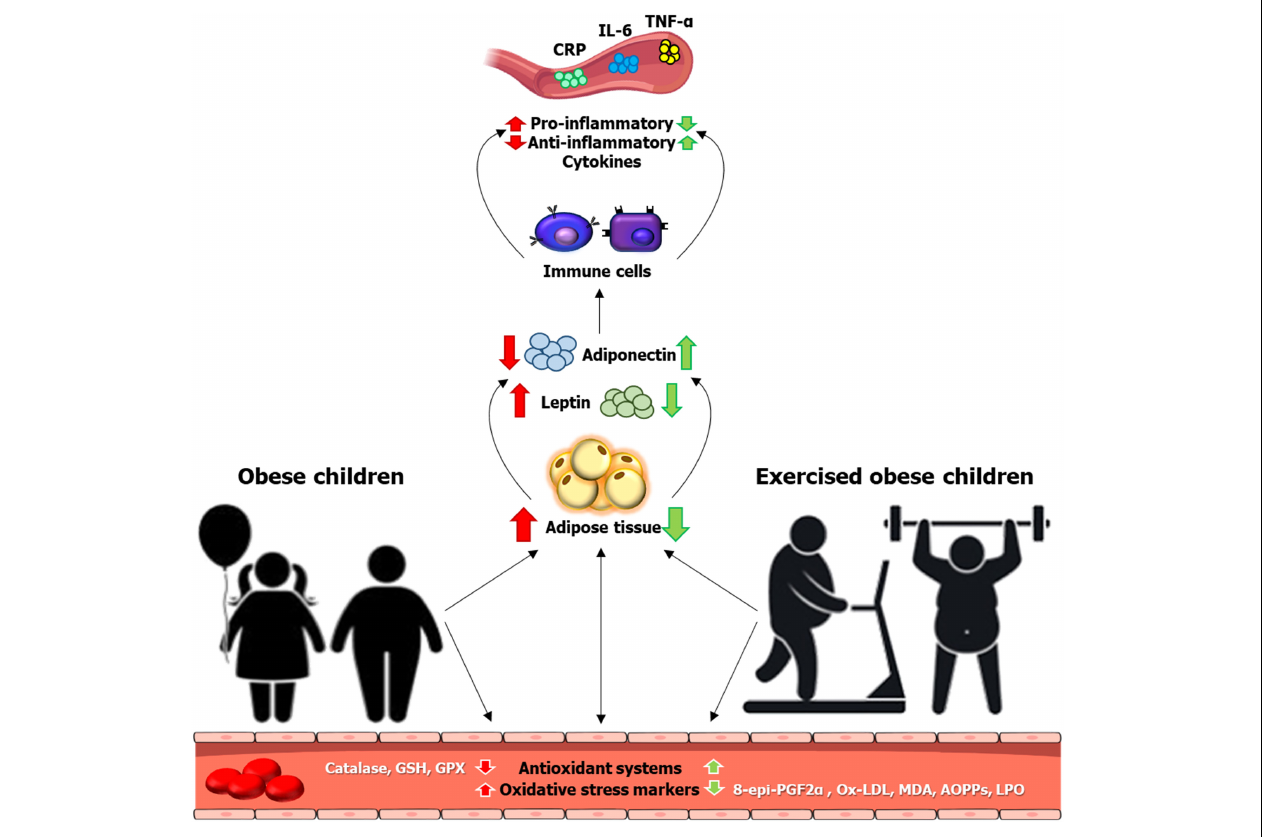
FIGURE 1 | Inflammation and oxidative stress responses to childhood obesity and exercise in obese children. Localized inflammation in adipose tissue related to obesity triggers low-grade systemic inflammation, manifesting in a general increase in circulating inflammatory markers in obese children. Childhood obesity concomitates with an oxidative status imbalance, increasing the oxidative stress markers and decreasing the antioxidant systems. Different protocols of physical activity might revert the consequences of obesity on inflammatory processes and oxidative stress during child growth. 8-epi-PGF2 α , 8-epi-prostaglandin F2 alpha; AOPPs, advanced oxidation protein products; CRP, C-reactive protein; GPX, glutathione peroxidase; GSH, reduced glutathione; IL-6, interleukin 6; LPO, lipoperoxides; MDA, malonaldehyde; ox-LDL, oxidized low-density lipoproteins; TNF- α , tumor necrosis factor